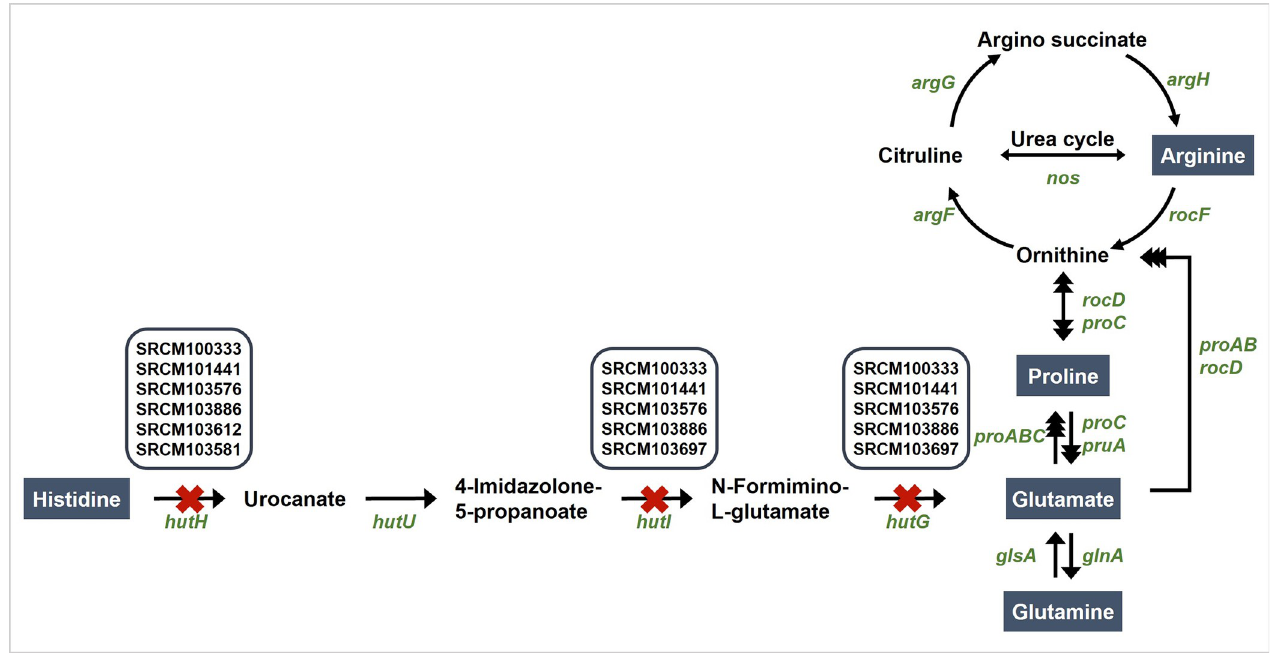
Fig 3. Biosynthesis pathway from histidine to glutamate in B . subtilis . Red crosses indicate strains that do not possess hutH , hutI , and/or hutG . Genes and amino acids are depicted in green italics and blue boxes, respectively. The black arrows correspond to potential enzymatic reactions catalyzed by gene products encoded in the genome of B . subtilis